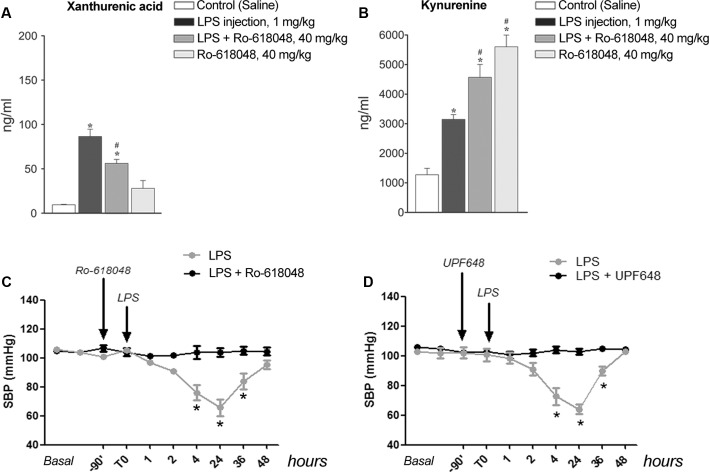
Lipopolysaccharide-induced hypotension is prevented by pharmacological blockade of kynurenine monooxygenase. (A,B) Serum levels of xanthurenic acid (XA) and L-kynurenine in mice injected i.p. with LPS (1 mg/kg) or vehicle 90 min after a pre-treatment with Ro-618048 (40 mg/kg) or its vehicle. Blood was collected from anesthetized mice 24 h after LPS injection. Values are means ± S.E.M. of three to four determinations. ∗p < 0.05 vs. control group (saline injection); #p < 0.05 vs. LPS; (One-way ANOVA + Fisher’s LSD). (C,D) SBP in conscious mice challenged with LPS (1 mg/kg, i.p.) after pretreatment with Ro-618048, UPF 648 or their relative vehicle. Values are means + S.E.M. of eight determinations. ∗p < 0.05 (Two-way ANOVA + Bonferroni’s Multiple Comparison Test).